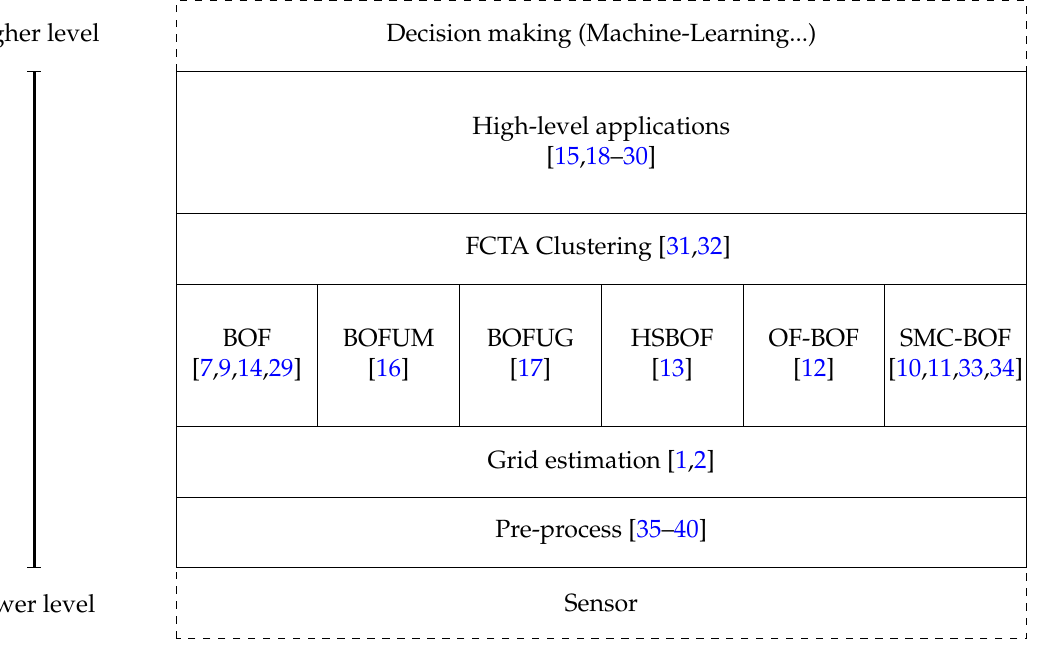
Figure 2. Taxonomy of Bayesian Occupancy